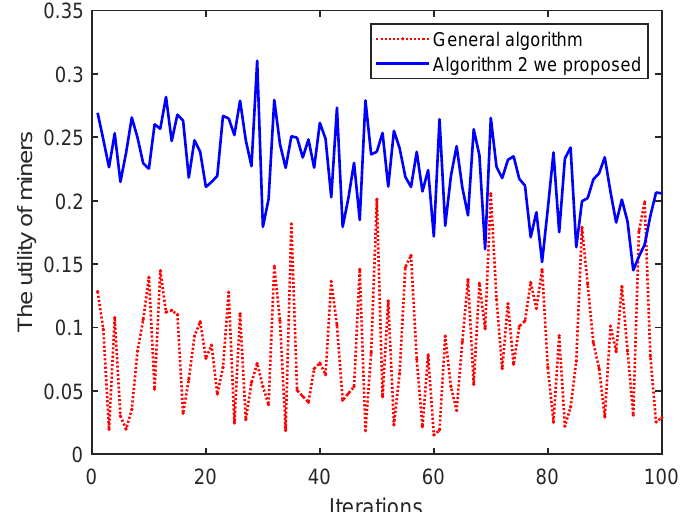
General algorithm Algorithm 2 we proposed